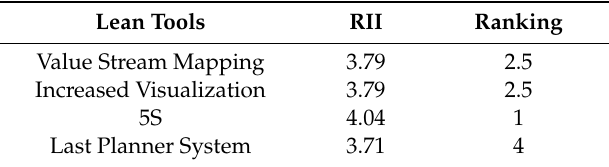
Table 7. RII and Ranking for Lean